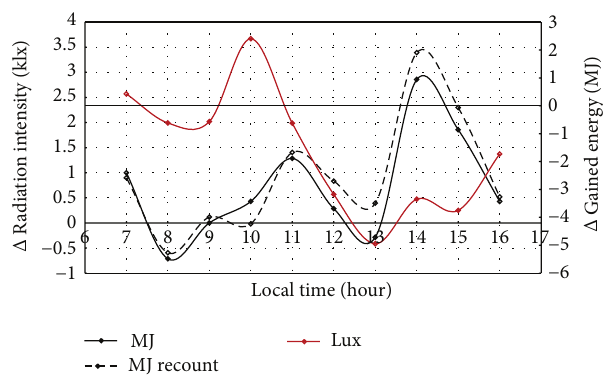
Figure 20: The courses of the values differences of the solar radiationintensityandtheamountofthegainedenergybytherotary system in relation to the fixed system (MJ is the left axis and the intensity is the right axis).